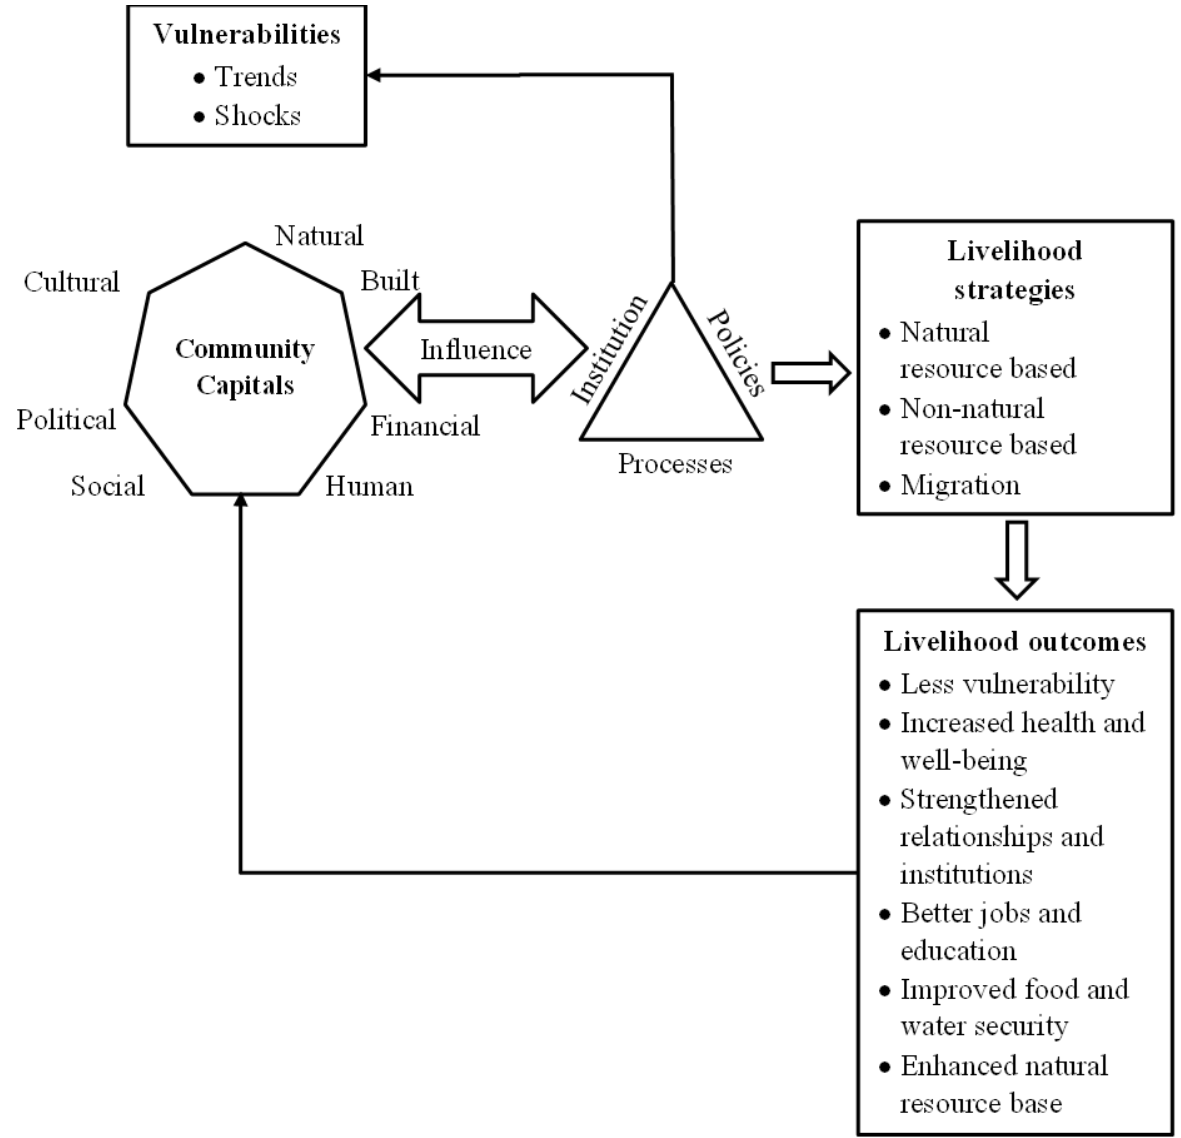
Increasing Rural Renewal through Sustainable Livelihoods and Community Capitals (RR-SLCC)